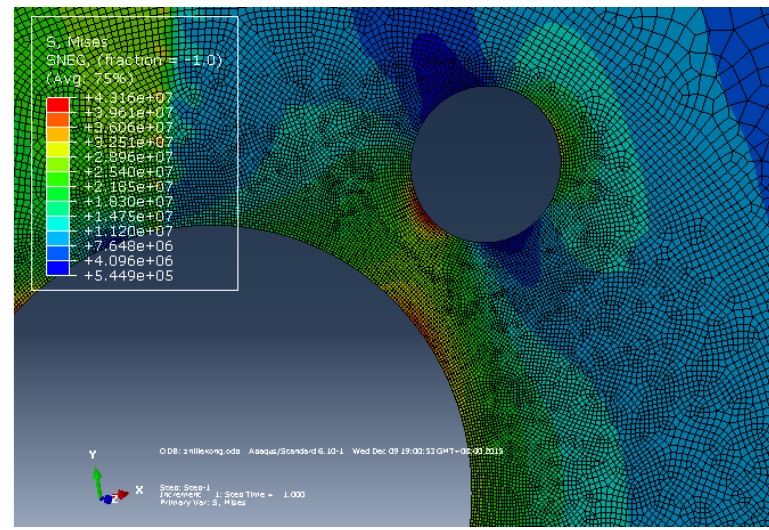
Figure 7. Stress cloud diagram after reinforcement of long-crack steel